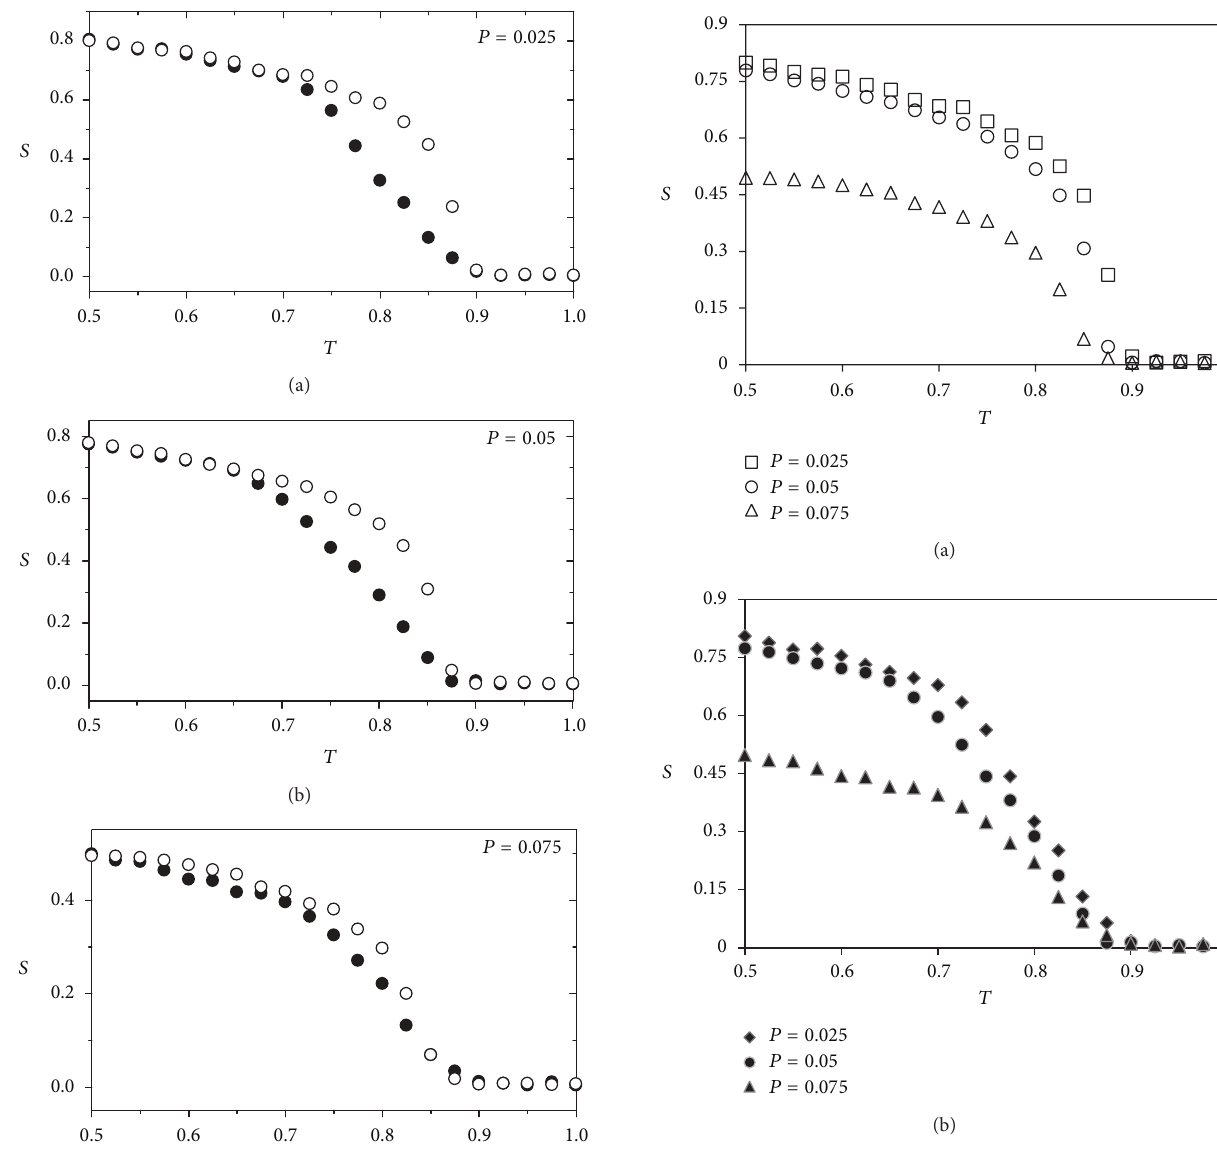
Figure 3: The degree of orientational ordering on (a) increasing and (b) decreasing 𝑇 , for different values of 𝑝 , 𝑁 = 60 , 𝑊 = 1